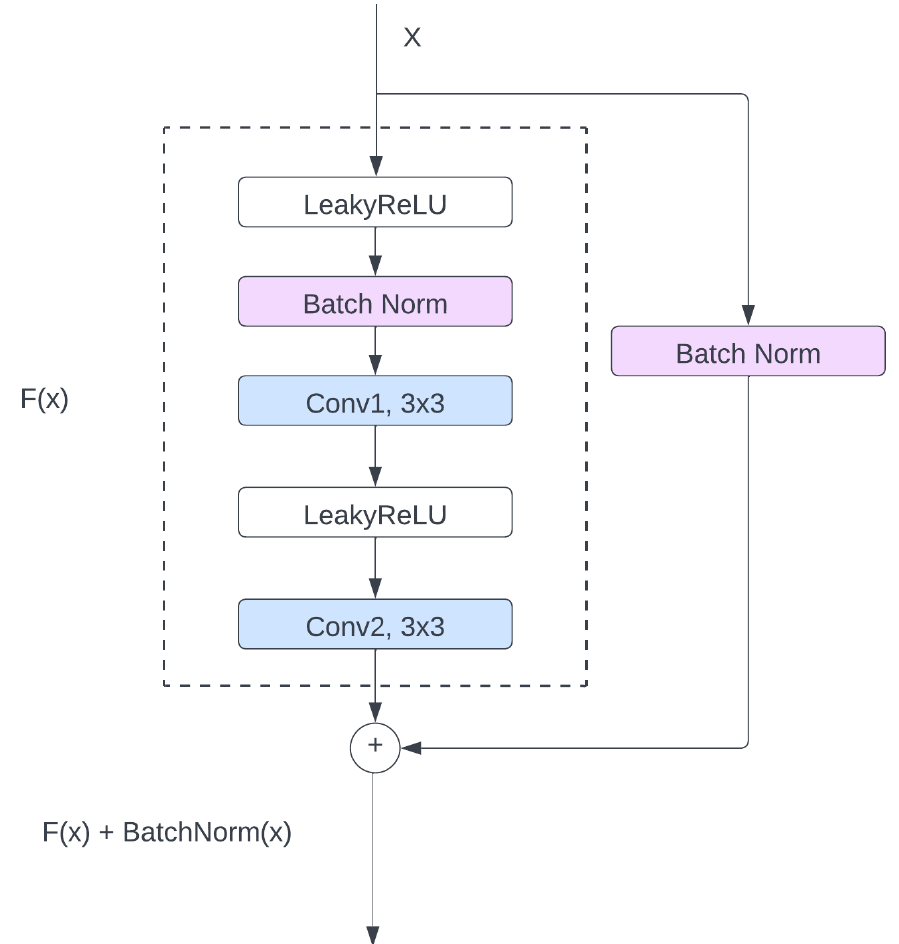
Figure 3. Residual